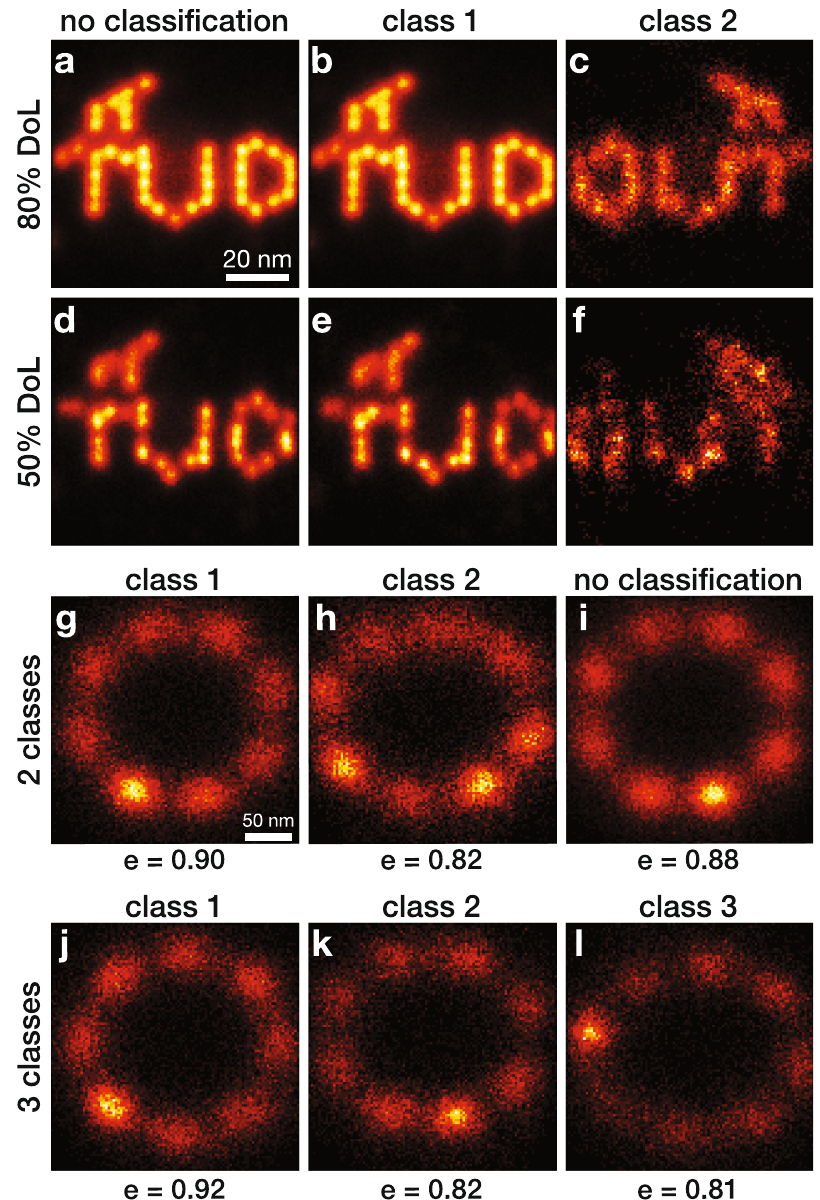
Fig. 3 Classi fi cation of fl ipped DNA Origami data and NPC data. a Fusion result without classi fi cation of 456 DNA-origami structures of the TUD-logo with 80% DoL. b , c The two classes resulting from the classi fi cation of a , containing 446 (normal orientation) and 10 ( fl ipped orientation) particles per class, respectively. d – f Same as a – c , but with 50% DoL and 381 and 8 particles per class, respectively. g , h The two classes resulting from the classi fi cation of i , containing 168 and 136 particles, respectively. We used K = 4 for the 80% DoL data and K = 40 for the 50% DoL data, followed by further grouping with the eigen image approach with C = 2 (Methods). i Fusion result without classi fi cation of 304 NPCs. j – l Same as g , h , but with classi fi cation into three classes, with 133, 90 and 81 particles per class, respectively. For g – l , the ellipticity values e are de fi ned as the ratio of the major axis over the minor axis of the ellipse fi tted to the localizations, and are indicated below each class. Scale bar of a applies to b – f . Scale bar of g applies to h – l